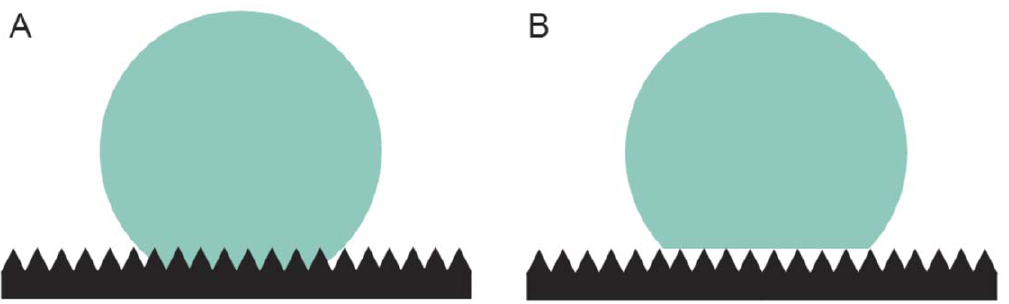
Figure 1. Diagram illustrating wettability behaviour of water on a rough surface. A . Wenzel wetting, where the water is in close contact with the surface. B. Cassie-Baxter wetting where air is trapped between parts of the surface and the drop.